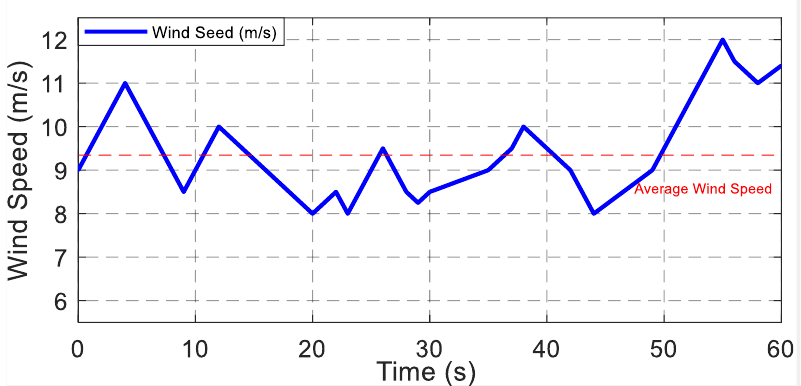
Figure 12. The real wind speed profile (9.40 m/s average speed). The generated active power graphics at this speed profile for both PI controller and PI with MPPT controller are shown in Figure 13.